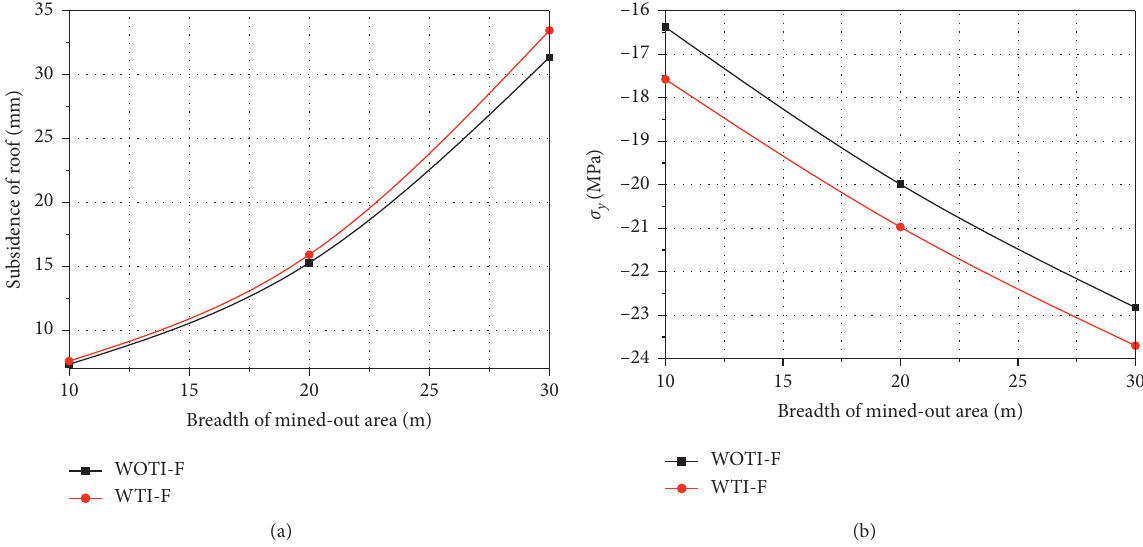
Figure 28: Analysis of calculation of forward direction fault with initial fracture. (a) Subsidence of the roof. (b) Vertical stress.